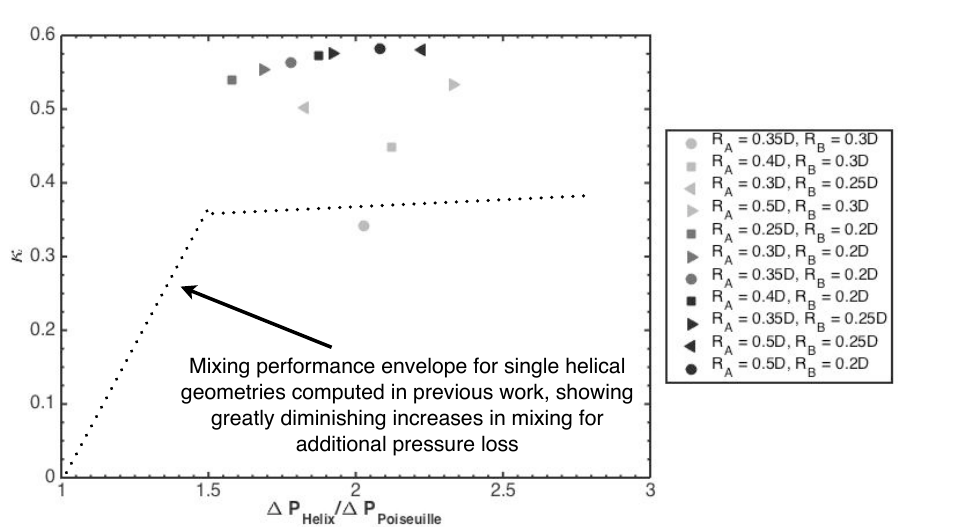
Figure 7. Relative entropy increase, κ , plotted against pressure drop, which has been normalised by the Poiseuille pressure drop that would occur over the equivalent axial, point-to-point distance. The black dotted line indicates the mixing trend obtained for the single helical geometries in previous work [1], highlighting the high cost of pressure drop required to achieve limited improvements in mixing in these geometries. These results show that all but one of the combined geometries show a substantial increase in κ for equivalent pressure losses over all the single